Question: Express in one sentence what the figure is showing.
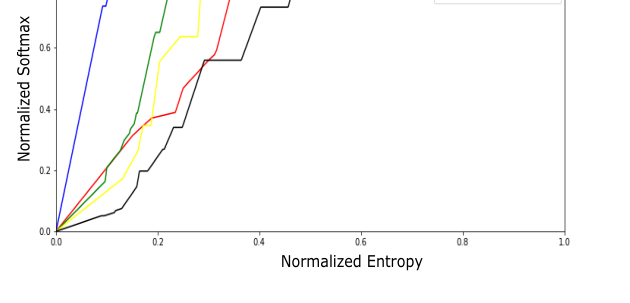
Answer: Quantitative comparison of saliency maps : Median Softmax Information curves